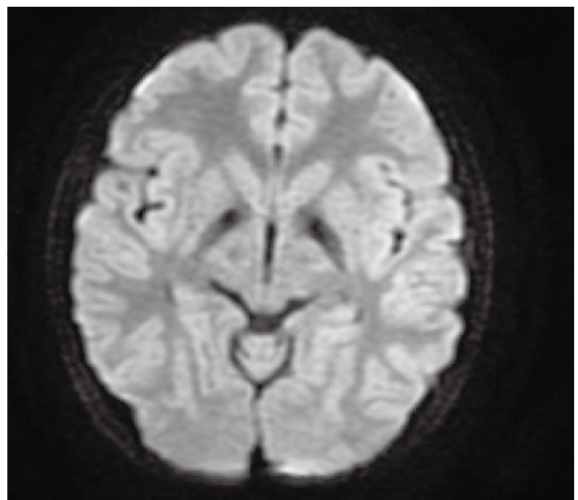
Figure 3: Axial T2 ∗ WI: showing hypointense signal in the corresponding